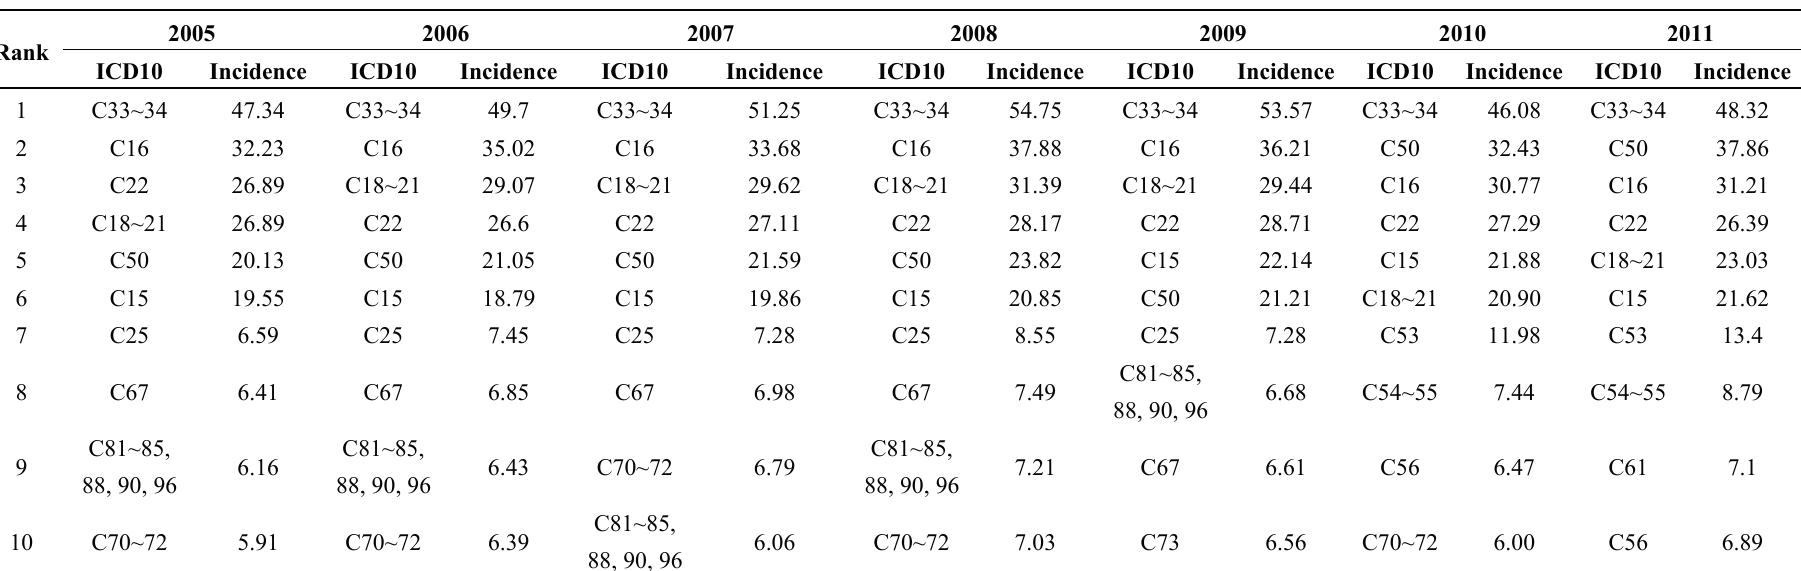
Table 2. Changes in the ranking of the top ten cancer incidences in China,